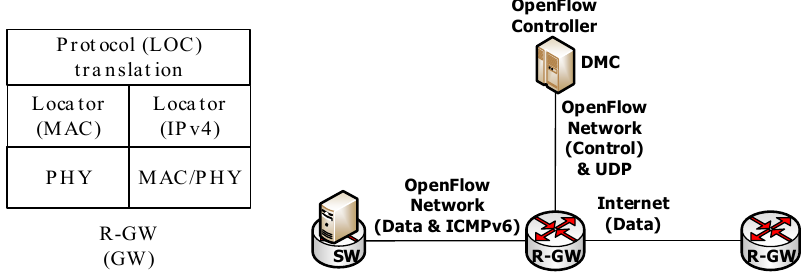
Figure 16. Protocol stack of the regional gateway (R ‐ GW) and connection with other entities.